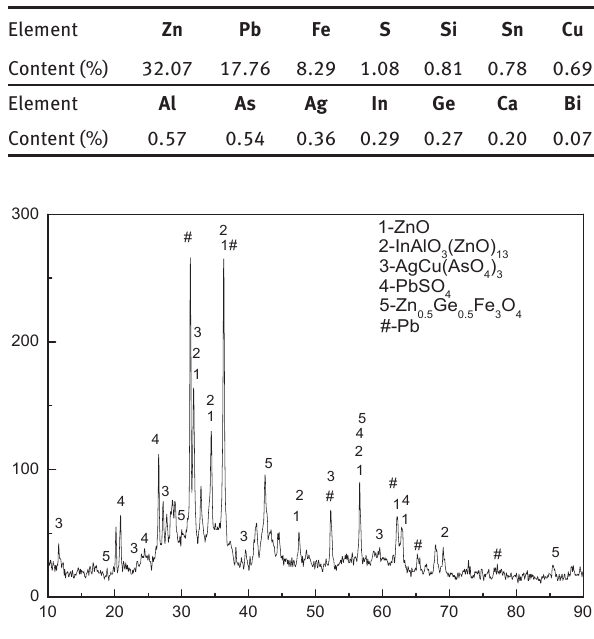
Figure 4: The XRD spectrum of raw materials.